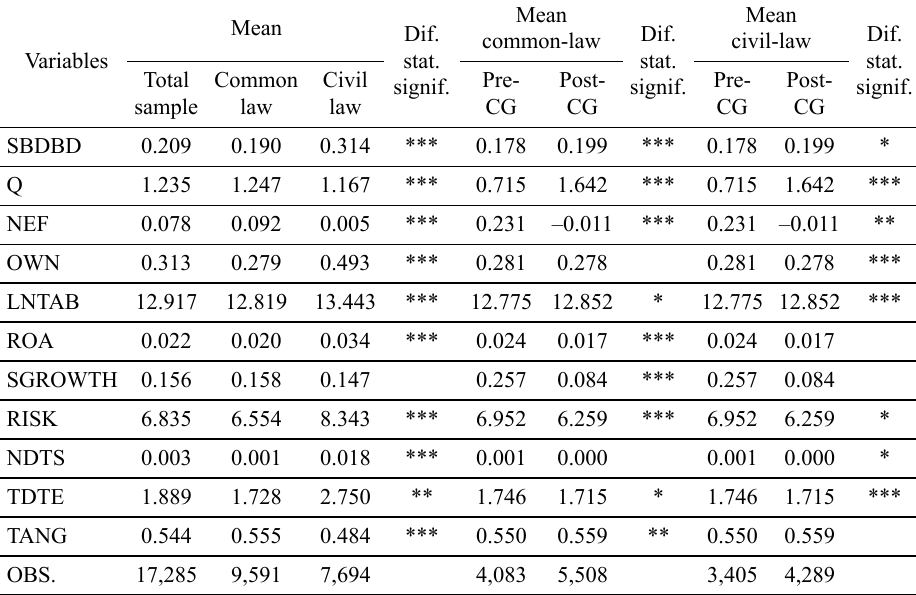
Table 1. Descriptive statistics and test of mean differences among the variables by legal system and application of corporate governance